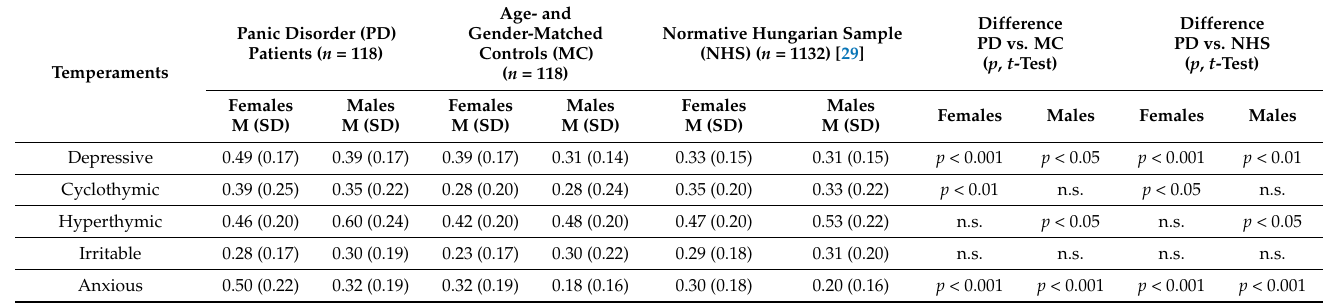
Table 3. Temperament Evaluation of the Memphis, Pisa, Paris, and San Diego Autoquestionnaire (TEMPS-A) subscale scores (means (M); standard deviations (SD)) and their comparisons (differences; t -test) compared between panic disorder patients (PD), age- and gender-matched controls (MC) and members of a large normative Hungarian sample